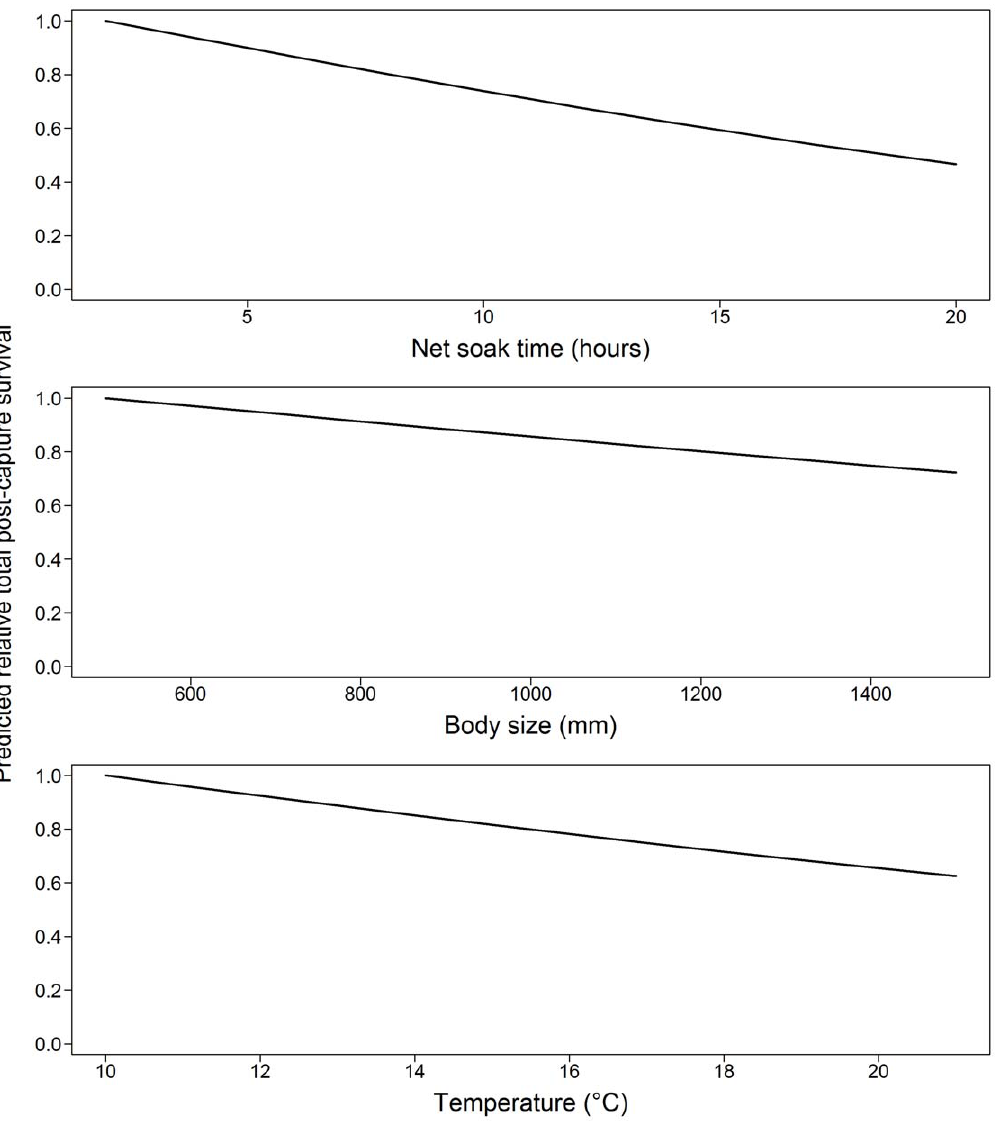
Figure 2. Predicted relative effect of net soak time, body size and temperature on total PCS. The analysis is based on 3224 observations for the six most abundant species.